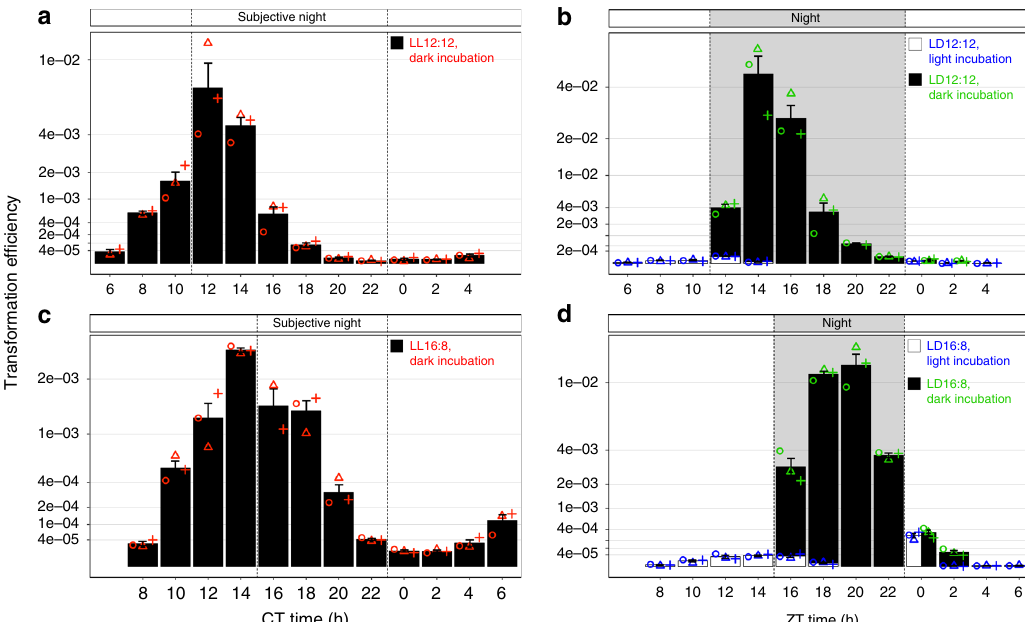
Fig. 5 Natural competence is under circadian control, requires external coincidence with darkness, and responds to changes in day length. Transformation ef fi ciency over a 24-h circadian cycle of cultures entrained with ( a , b ) 12-h day length, and ( c , d ) 16-h day length under ( a , c ) constant light, and ( b , d ) light-dark conditions. Ef fi ciencies were calculated as the number of antibiotic-resistant colonies per CFU without selection upon transformation of three biologically independent cultures (circles, triangles, and plus signs) and plotted as mean values ± SEM on a square-root scale. White and black bars are either overlaid or shown side-by-side to make both values visible. Source data are provided as a Source Data fi